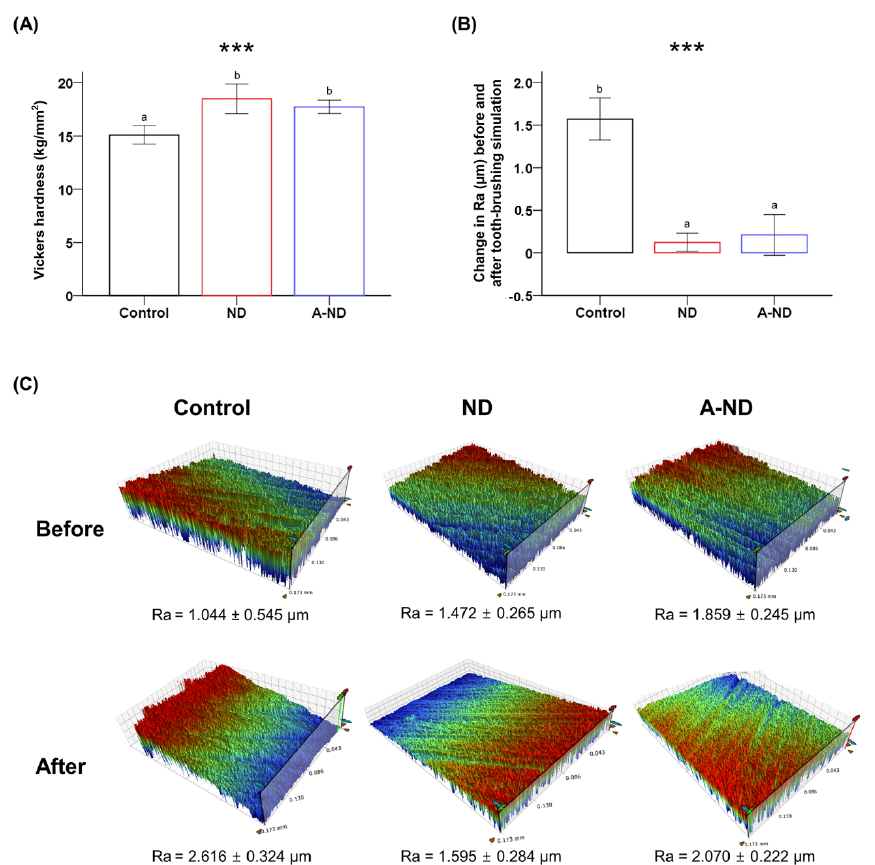
Figure 7. Comparing ( A ) Vickers hardness and ( B ) the mean di ff erences in surface roughness before and after simulated toothbrushing. ( C ) Representative 3D profilometric images of the samples before and after brushing with mean roughness (Ra) values. *** p < 0.001 for comparison between the groups.